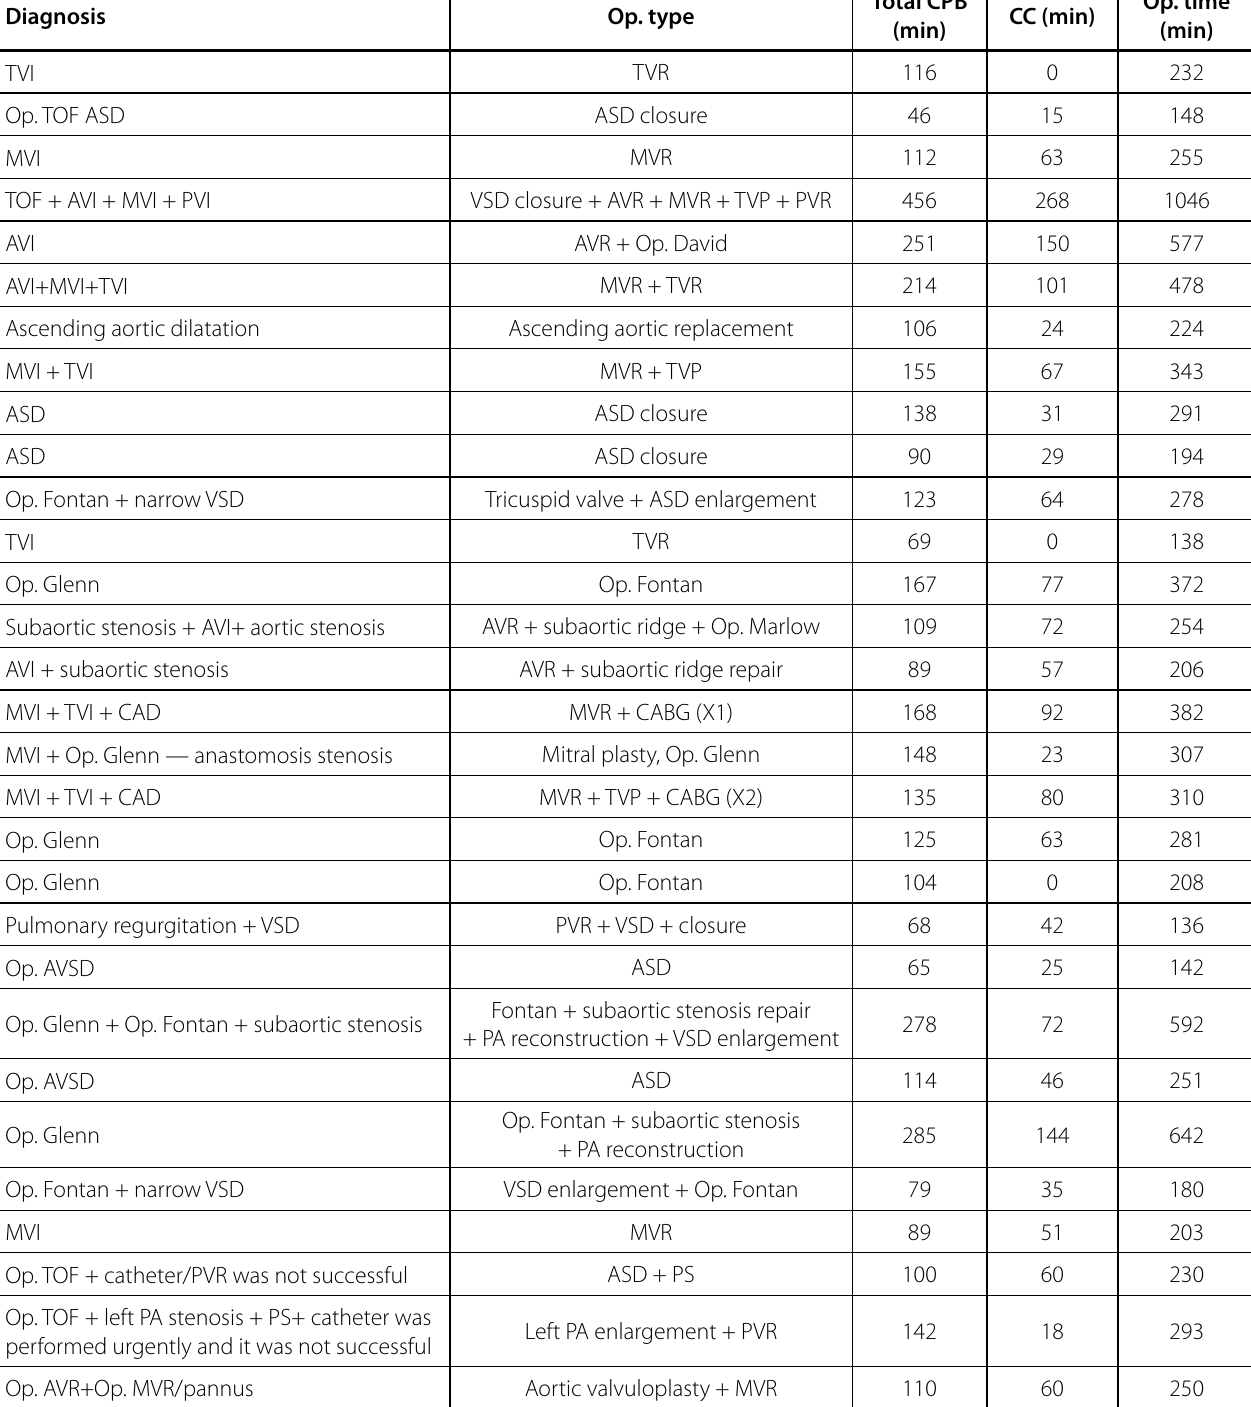
Table 3 . Features of the preoperative USG-guided cannulation group (diagnosis, operation type, and durations).